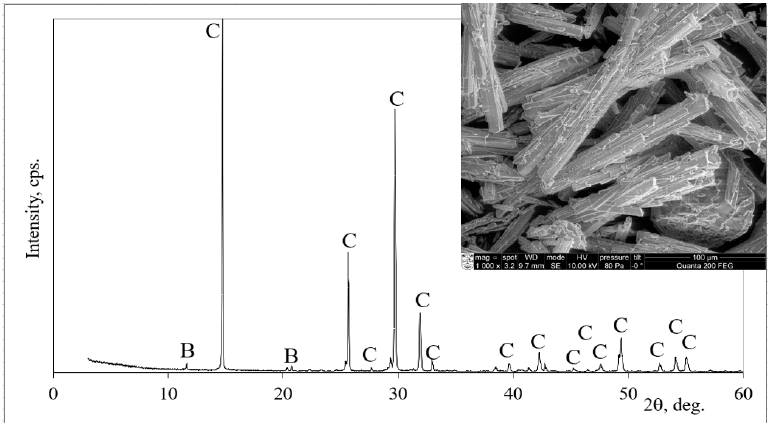
Figure 4. The mineral composition (X-ray analysis) and microstructure of phosphogypsum. Notes: C—basanite, CaSO 4 ·0.5H 2 O (33–310); B—brushite, CaPO 3 (OH)·2H 2 O (11–293).